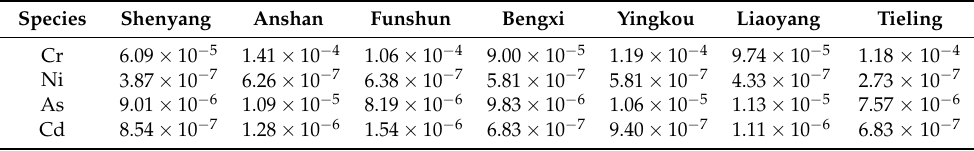
Table 1. Carcinogenic risks of metal elements at seven cities.